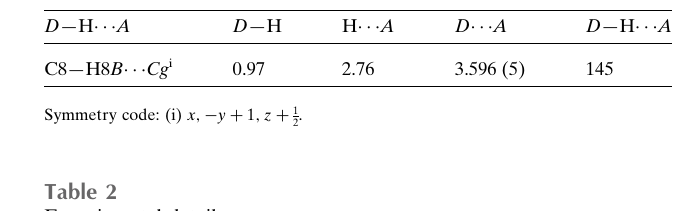
Table 1 Hydrogen-bond geometry (A˚ , (cid:4) ).